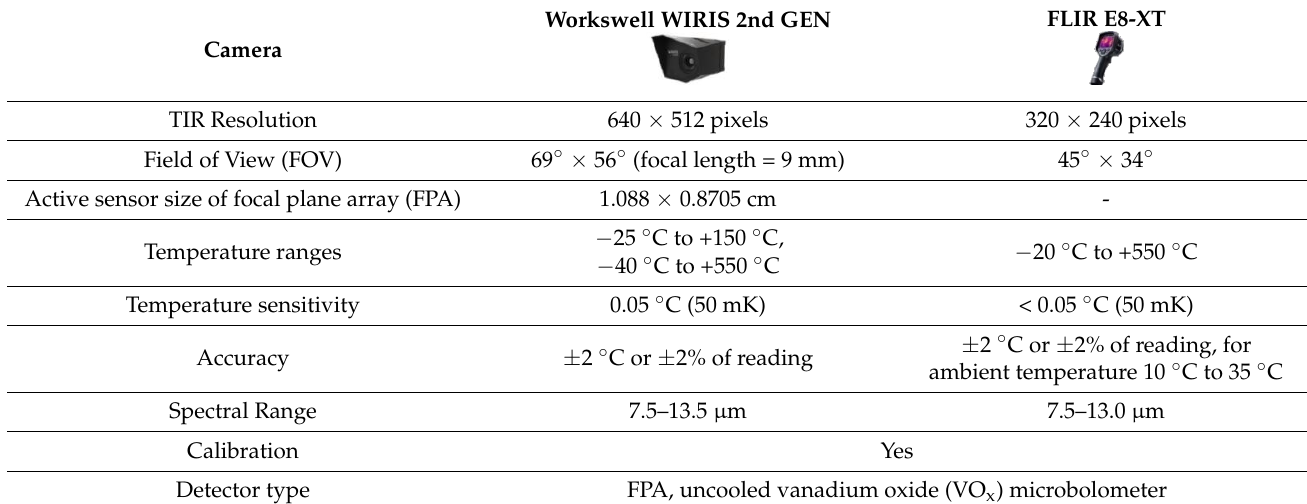
Table 1. The technical specification of used miniaturized thermal infrared (TIR) cameras. Camera